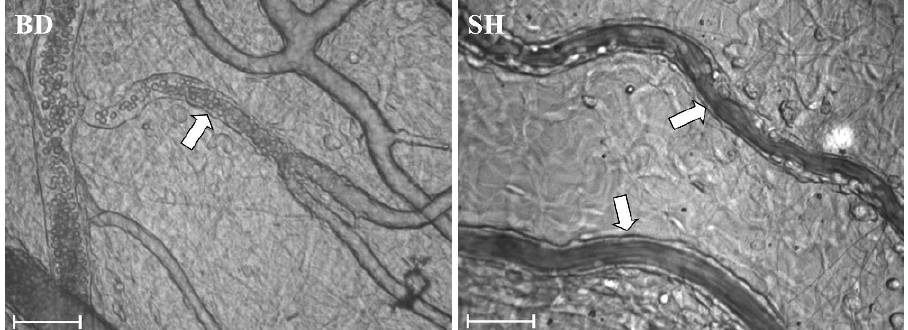
Figure 2 - Photomicrographs of rat mesenteric microvessels. The arrows indicate post-capillary venules in brain-dead (BD) and sham- operated (SH) animals. Bar=50 m